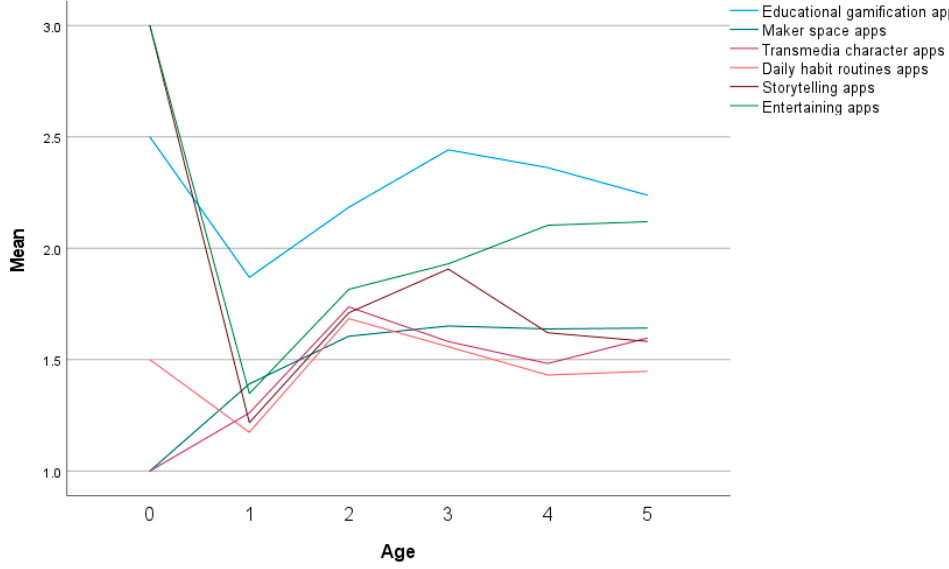
Figure 10. Application types that parents offer to a child according to the child’s age. Gender mean differences are small with larger how much parents offer entertaining apps to a child, with the girls’ showing lower means (M = 1.86, SD = 1.12) vs. boys’ mean (M = 2.05, SD =